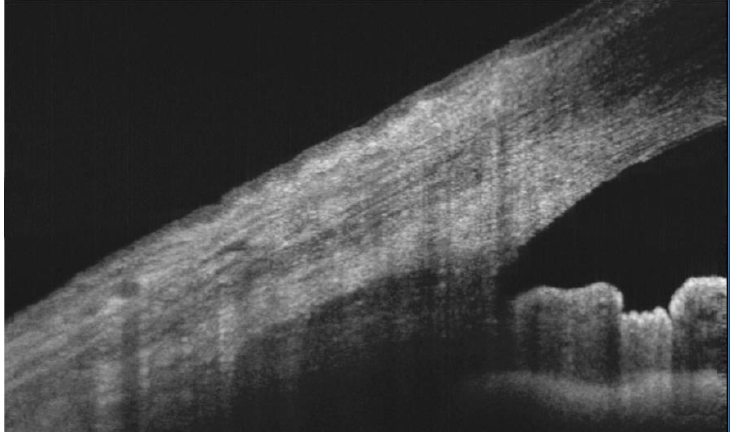
Figure 8. Optical coherence tomography (OCT) imaging of the ocular surface epithelia. The epithelia of the ocular surface (especially conjunctiva, limbus, and cornea) can be accurately visualized and quantified by OCT imaging (as a continuous, hypo-reflective structure). This approach may be useful to diagnose and monitor a wide variety of pathological situations (see text).